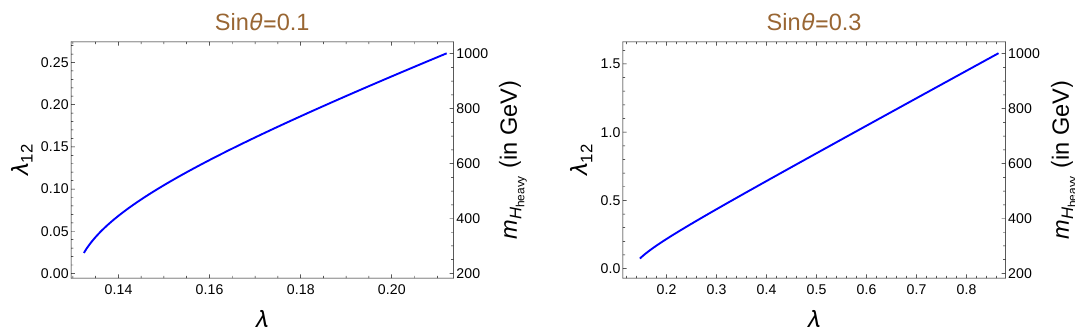
Figure 3 . The correlation of (cid:21) vs (cid:21) 12 for high mass region with heavy Higgs ranging between 200 GeV (cid:20) m H (cid:20) 1000 GeV for sin (cid:18) = 0 : 1 (left panel) and sin (cid:18) = 0 : 3 (right panel) heavy